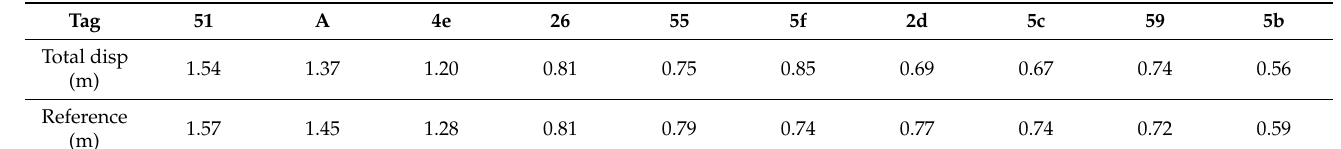
Figure 9. Cumulative 2D displacement norm for each tag, with reference measurements performed via tacheometer (black crosses). An offset was added to every plot to increase readability. The total displacement values are given in Table 3. Table 3. Total 2D displacement norm for all presented tags computed from the RFID phase, from Jan- uary 2021 to February 2022. The reference is computed from the tacheometry measurements, with an estimated error of ± 4 cm.